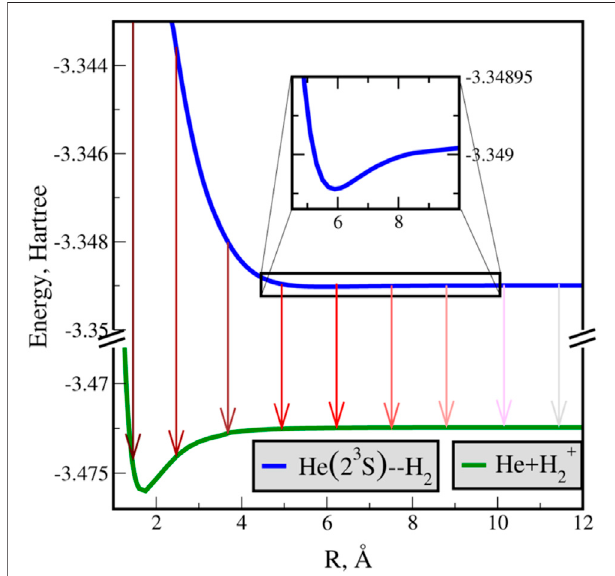
FIGURE8| Potentialenergycurvesoftheneutral-excited(He( 3 S,1s2s)+ H 2 ,inblue)and cation (He( 1 S,1s 2 )+H + 2 ,ingreen)systemsat ϕ = π /2.Energies are in Hartrees and the intermolecular separation in angstroms. The excited (blue) state is approximated as bound state in the continuum, i.e., using standard Hermitian formalism. In addition, decay rates are presented schematically by red arrows (according to the RVP results presented below). The intensity of the red color re fl ects the decay rate from the neutral-excited state to the cation state, where stronger intensities indicate higher decay rates. Enlarging the region around 6 (cid:2) A , see inset, reveals a shallow well. The experimental observation of the autoionization process is associated with this region [81]. Reprinted (adapted) with permission Ref. [67]. Copyright (2017) American Chemical